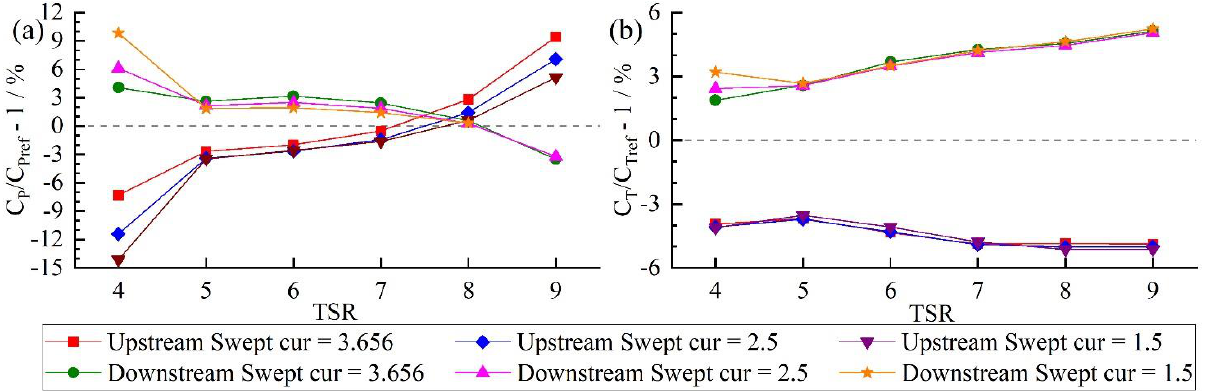
Figure 16. Variation owing to swept blades with different curve exponents in C P and C T ; (a) for C P , and (b) for C T .